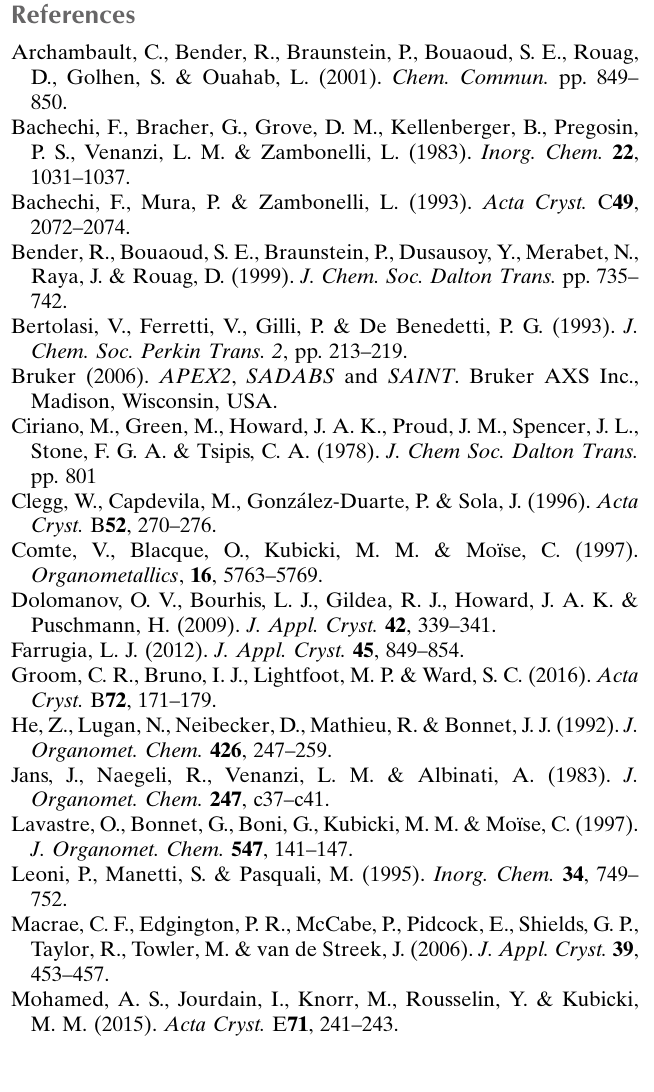
Table 3 Experimental details. Crystal data Chemical